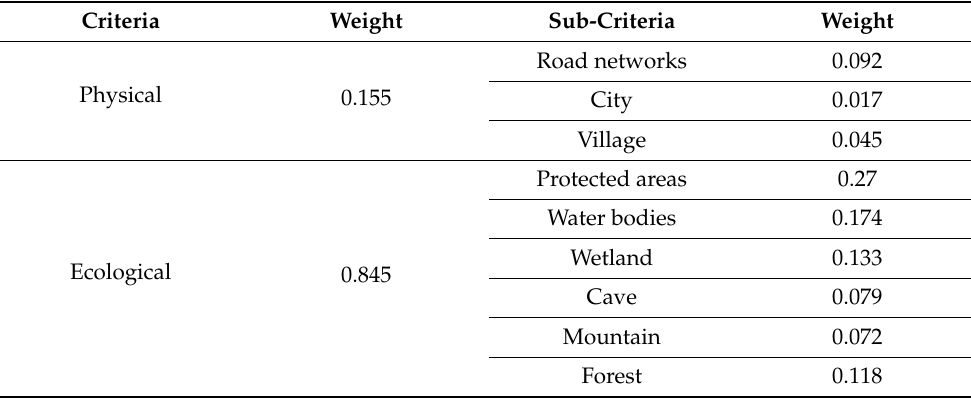
Table 2. The weights of the criteria and